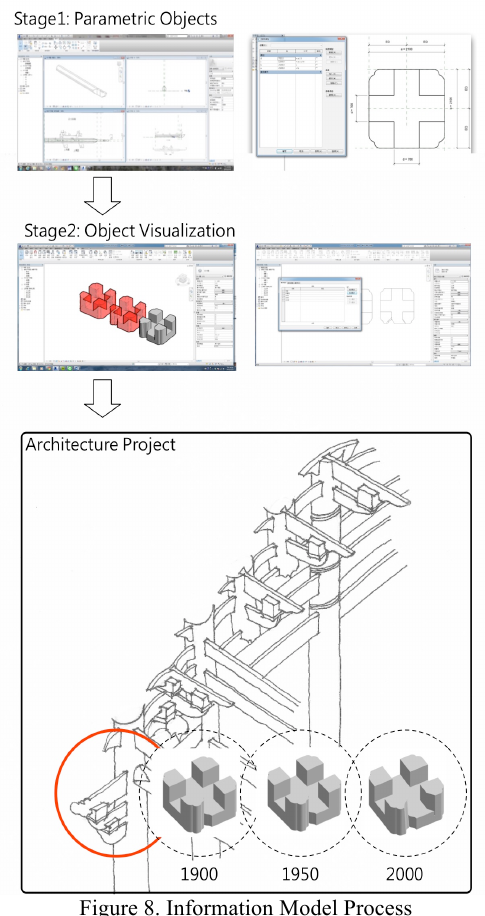
Figure 9. The 2D/3D visualization drawings for different dimensions of objects could be rapidly made and applied Figure 8. Information Model Process required sizes into boxes and using the functions of Autodesk Revit Architecture to modify the sizes and forms of the